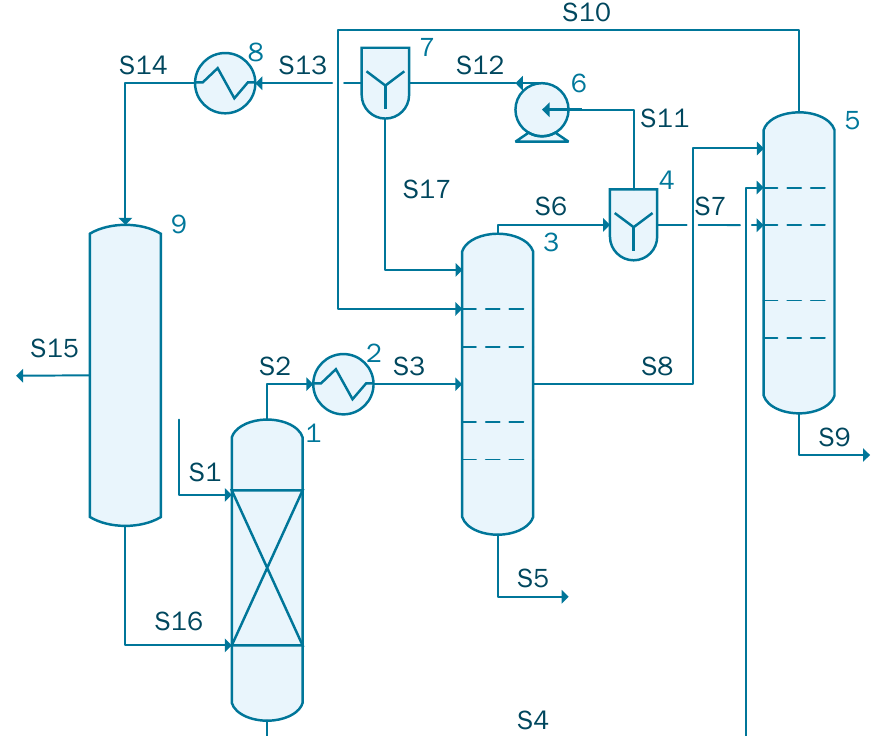
Figure 5. Process flow diagram of the acetic acid concentration with TC (case 4). The stream S1 containing 1000 kmol/h of acetic acid solution with the following mole flow-rate: 861 kmol/h of water and 139 kmol/h acetic acid is sent to unit 1 where it is